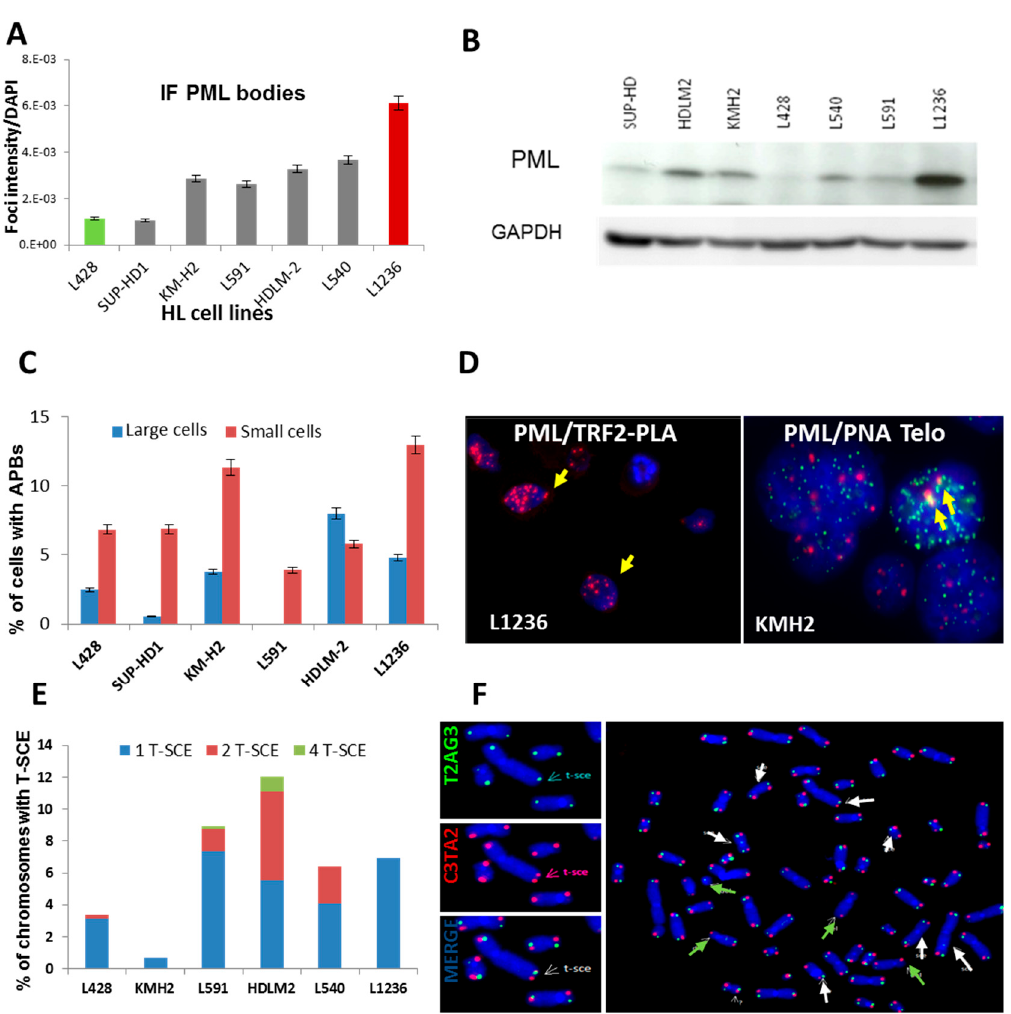
Figure 2. Charaterization of the alternative telomere lengthening (ALT) phenotype in HL cell lines. ( A ) Quantification of PML bodies in HL cell lines by immunofluorescence. Ten thousand cells were analyzed for each cell line. ( B ) Western blots of PML protein in HL cell lines. Glyceraldehyde-3-phosphate dehydrogenase (GAPDH) was used as a loading control. ( C ) Frequency of small and large cells with colocalization of TRF2 and PML by the PLA assay. ( D ) Representative cells with colocalization of PML and TRF2 by the PLA assay (yellow arrow) and the manual colocalization of PML (red) and PNA-telomeres (green) (yellow arrow) (40 × magnification). ( E ) Quantification of T-SCE in chromosomes of HL cell lines after CO-FISH staining. Chromosomes with (i) one T-SCE event, (ii) with two T-SCE events assessed by simultaneously using both leading- and lagging-strand probes, and (iii) with four T-SCE events on both strands and on both the p and q arms were assessed. ( F ) Image of metaphases with T-SCE (white arrow) in KMH2 cells and telomere deletions (green arrow) (63 × magnification).